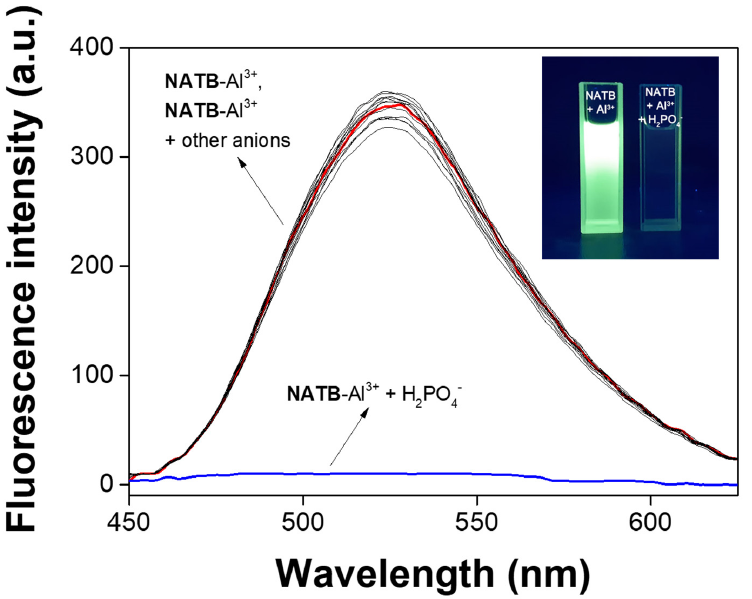
Figure 7. Fluorescence changes of NATB -Al 3+ (30 μ M) with various anions (45 μ M) in MeOH ( λ ex : 358 nm). Photograph: the fluorescent images of NATB- Al 3+ and NATB -Al 3+ -H 2 PO 4 − ( λ ex : 358 nm).